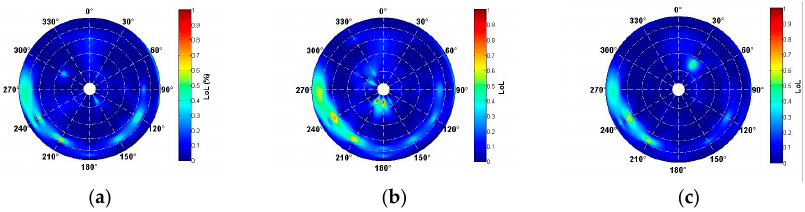
Figure 6. Spatial statistics of loss of lock percentage by scintillation. ( a ) 2013; ( b ) 2014; ( c ) 2015.